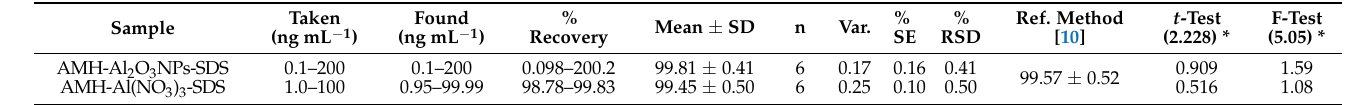
Table 6. Assay of AMH in its commercial syrup applying the proposed Al 2 O 3 NPs-SDS and Al(NO 3 ) 3 - SDS spectrofluorometric